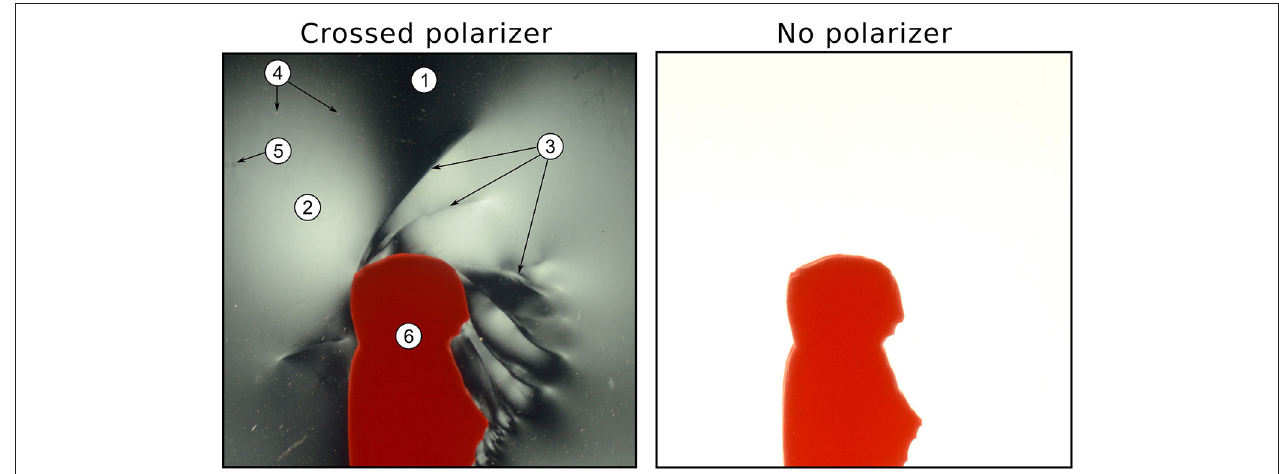
FIGURE 3 | Left: Characteristic polarized photograph displaying birefringence patterns in the laponite gel. (1) Dark, unstrained gel. (2) Diffused birefringence lobe. (3) Hairline birefringence jumps. (4) White patches of laponite particle clusters. (5) Crossed patterns of birefringence around a rigid impurity in the gel. (6) Red oil. Right: photograph (same area/time) without polarizer. Note the lack of features shown in the gel in the unpolarized photograph as compared to the polarized photograph.